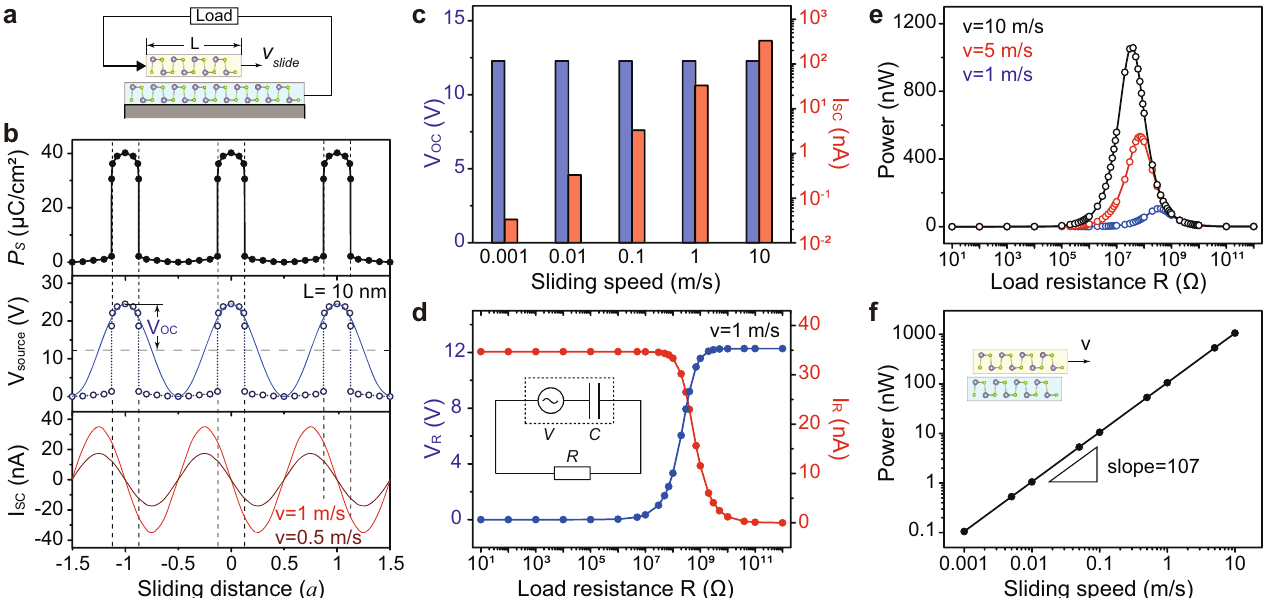
Fig. 4 NG using the tribo induced FE-to-AFE phenomenon — theoretical model prediction. a Schematic illustration of a FE-to-AFE-based NG in connection with an external load resistor. The theoretical models were adopted from ref. 47 (see the main text and the SI for details). b Variation of polarization, source voltage ( V source ), and short-circuit current ( I sc ) of a 10 × 10 nm NG under a 1 m s − 1 sliding speed. Three sliding periods are shown. The considerably large values of V source and I sc bene fi t from the large polarization change and large polarization rate during the interlayer sliding process (see the main text for details). The voltage exhibits a linear relation with the polarization change and is simpli fi ed as a sinusoidal alternating voltage in subsequent modeling and discussion. c Dependence of V oc and I sc on the interlayer sliding speed. The voltage is independent of the sliding speed because of the constant polarization change (see the main text). I sc is linearly related to the sliding speed because of its linear relation with the rate of polarization change. d Dependence of the voltage and current output under a 1 m s − 1 sliding speed as a function of the load resistance. The inset is the equivalent circuit of the FE-to-AFE-based NG. e Power output as a function of the load resistance at different sliding speeds. f Maximum power at different sliding speeds obtained from the theoretical